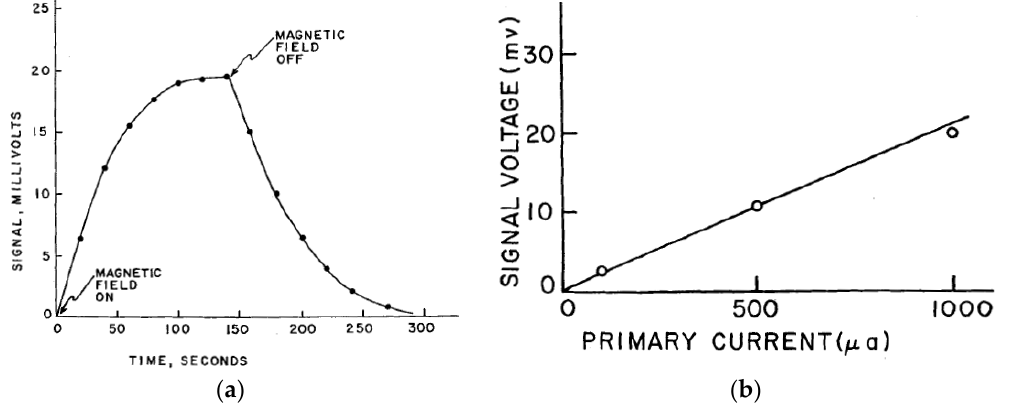
Figure 4. ( a ) Hall voltage measured upon application of a magnetic field as a function of time, 0.01 M CuSO 4 aqueous solution. ( b ) Hall voltage as a function of electrochemical current, in 0.01 M CuSO 4 (Reproduced with permission from [23], Taylor & Francis, 1972).